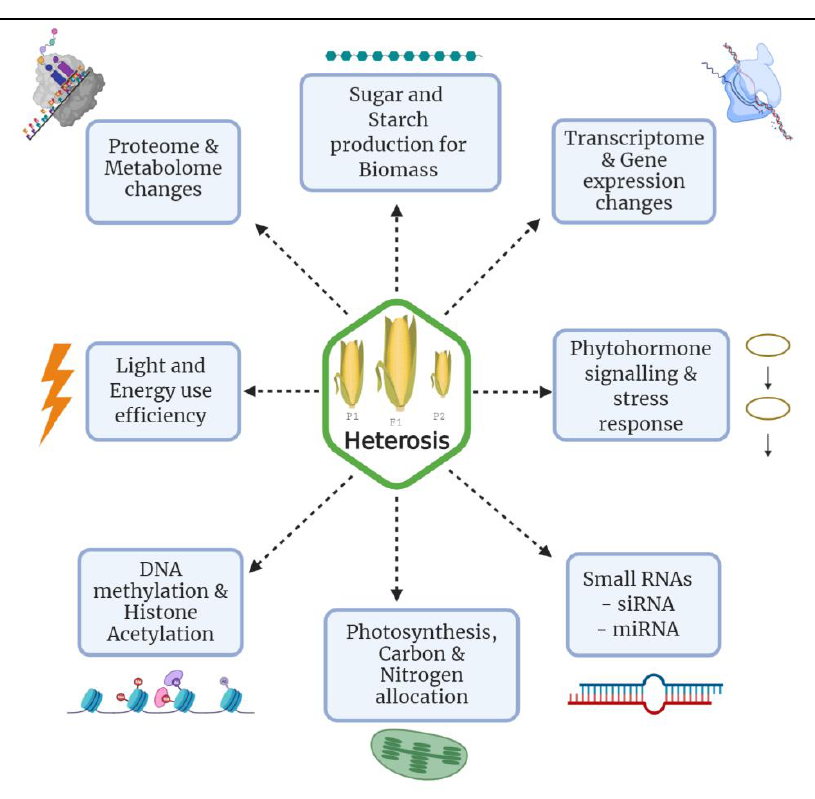
Figure 6. Different physiological and molecular mechanisms involved in manifestation of hybrid